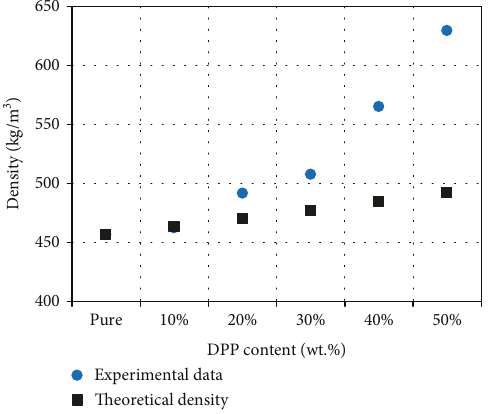
Figure 5: Composite density for di ff erent fi ller